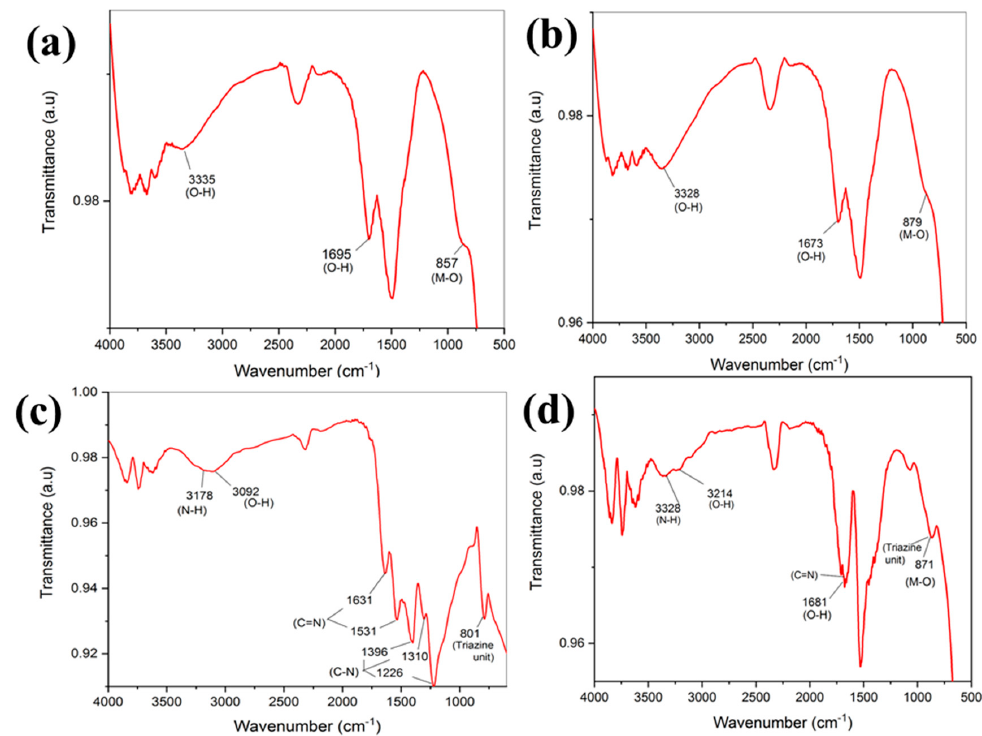
Figure 2. FTIR spectrum of composites of ZnFe 2 O 4 ( a ), S-g-C 3 N 4 ( b ), 9% Mn-ZnFe 2 O 4 ( c ), and 9% Mn-ZnFe 2 O 4 /50S-gC 3 N 4 ( d ). Mn-ZnFe 2 O 4 /50S-gC 3 N 4 ( d